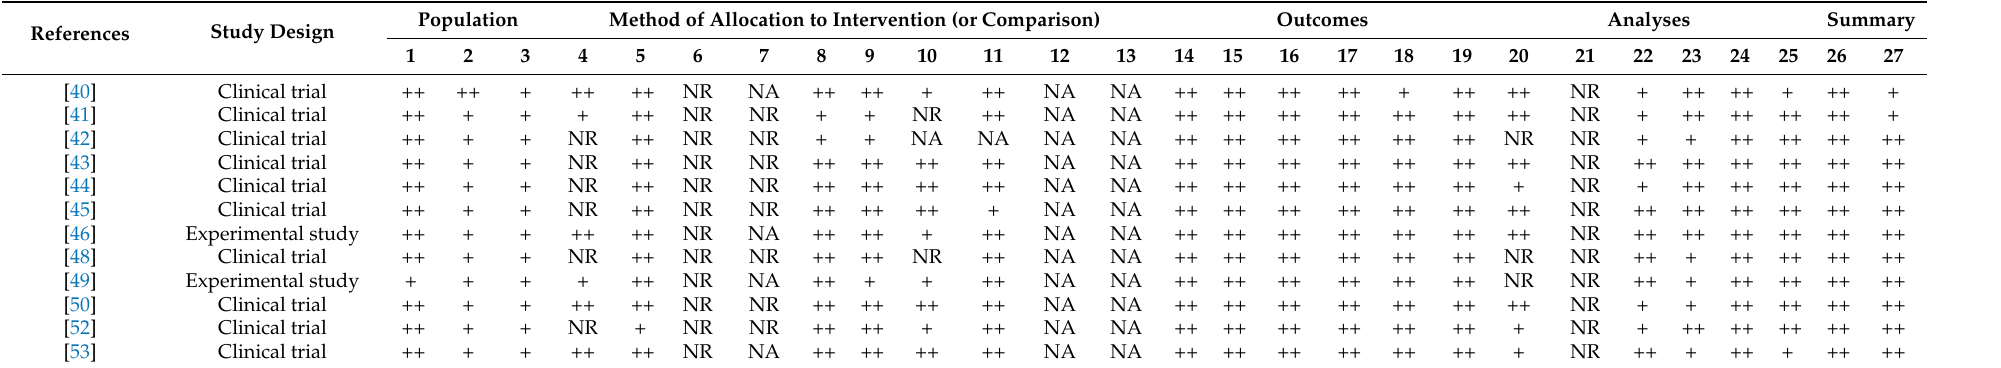
Table 3. National Institute for Health and Care Excellence Methodology Checklist: quantitative